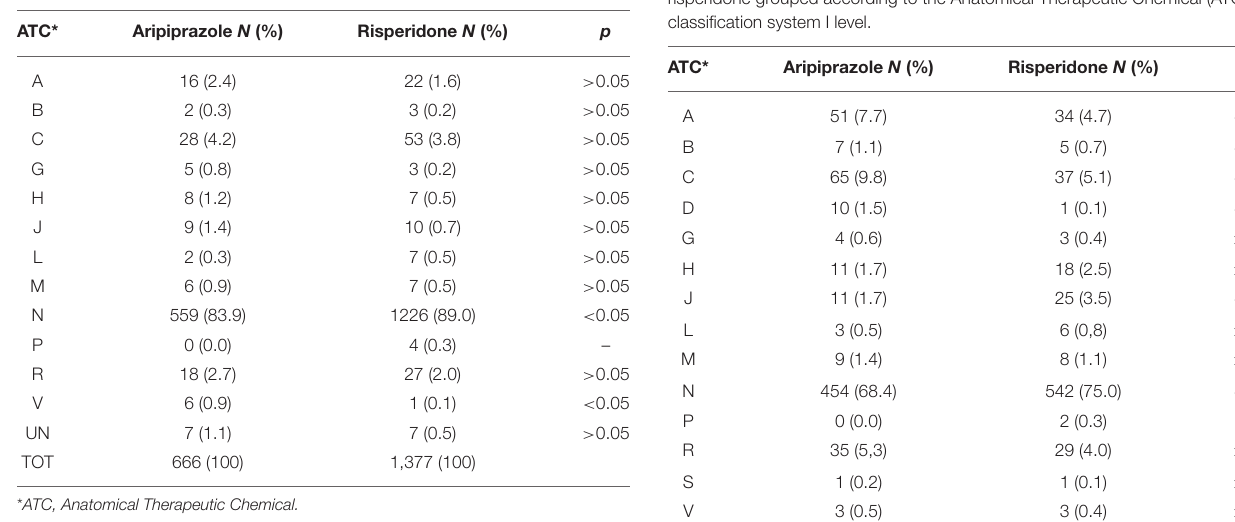
TABLE 7 | Distribution of other suspected drugs reported with aripiprazole and risperidone grouped according to the Anatomical Therapeutic Chemical (ATC) classification system I level.